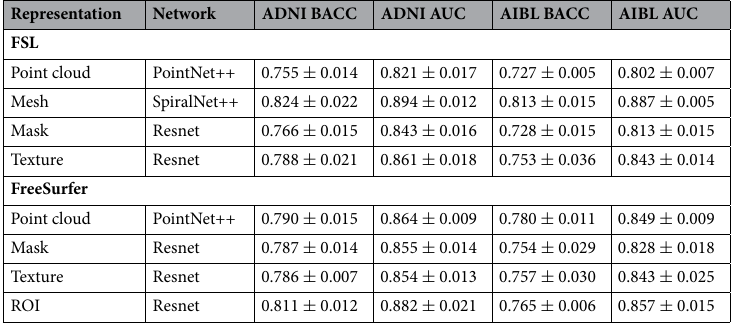
Table 1. Classification results (BACC: balanced accuracy, AUC: Area under the ROC curve) on ADNI and AIBL for different representations. Top: Segmentations obtained using FSL FIRST software. Bottom: Segmentations obtained using FreeSurfer software.